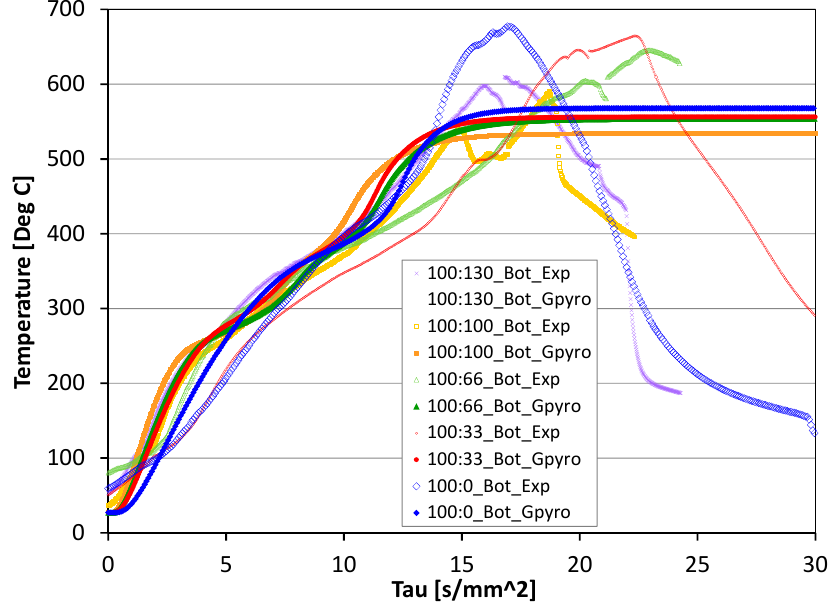
Figure 9. Experimental and simulated unexposed face temperatures (Tau is the time divided by sample thickness squared).